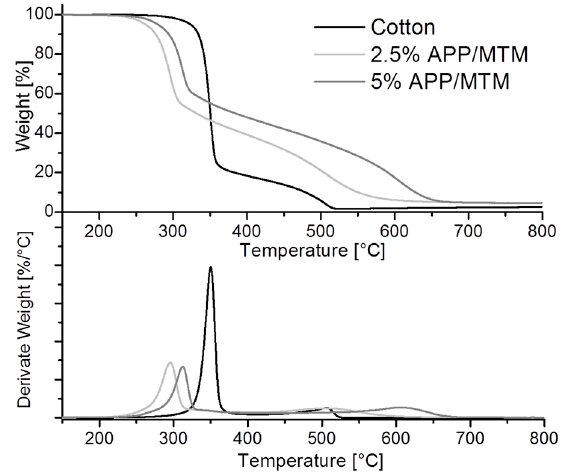
Figure 3. Thermogravimetric (TG) and derivative (dTG) curves of untreated and treated cotton fabrics in air. Table 2. Thermogravimetric data of untreated and treated samples in air.